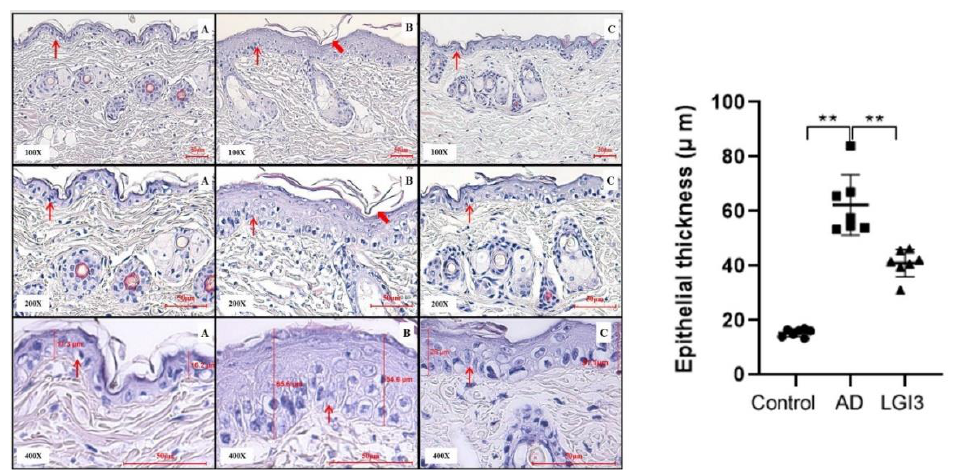
Figure 6. Thickness of epithelial cell layer of dorsal skin measured by the light microscopy. Representative photomicrographs of dorsal skin on day 15 from each group of mice: H&E staining (100×, 200×, 400×). ( A ) Dorsal skin of the control group; ( B ) dorsal skin of the atopic dermatitis (AD) group; ( C ) dorsal skin of the leucine-rich glioma inactivated 3 (LGI3) group. The thin arrow indicates the epithelial skin tissue and the thick arrow indicates parakeratosis. Remarkable suppressive effect has been demonstrated in abnormal epidermal thickness of dorsal skin (37.3 ± 8.75 μm, P < 0.01) in the LGI3 group (N = 7). Data are expressed as mean ± S.D. (** P < 0.01 vs. AD model).